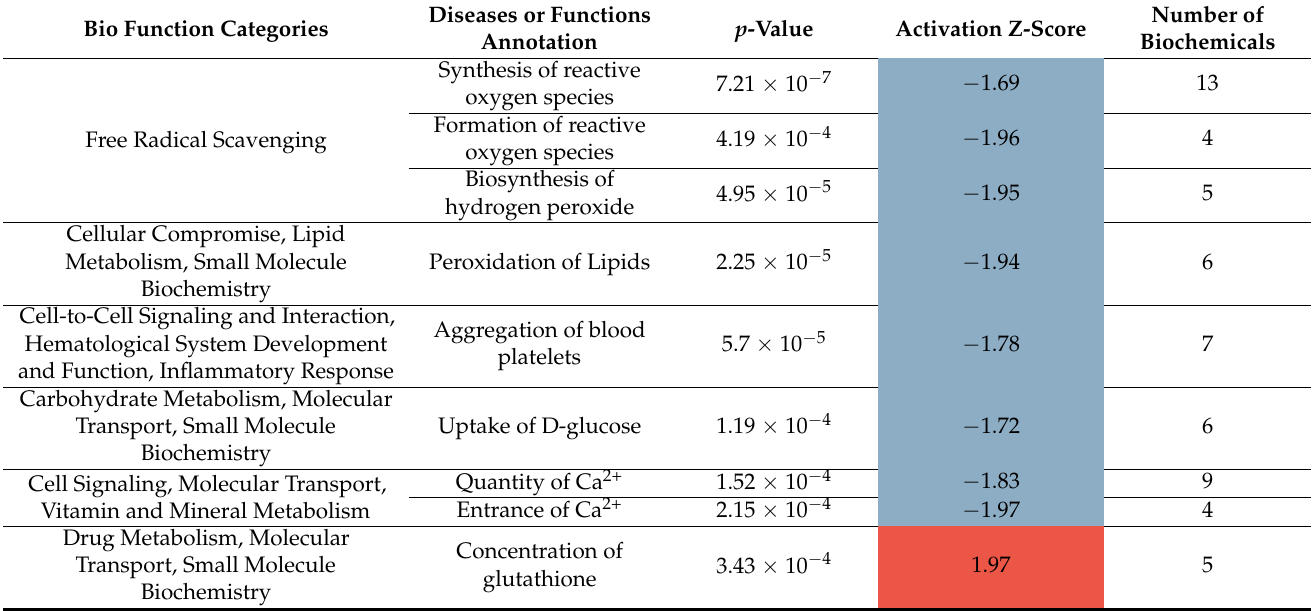
Table 7. Top bio functions reported by IPA of significantly changed metabolites post omega-3 PUFA